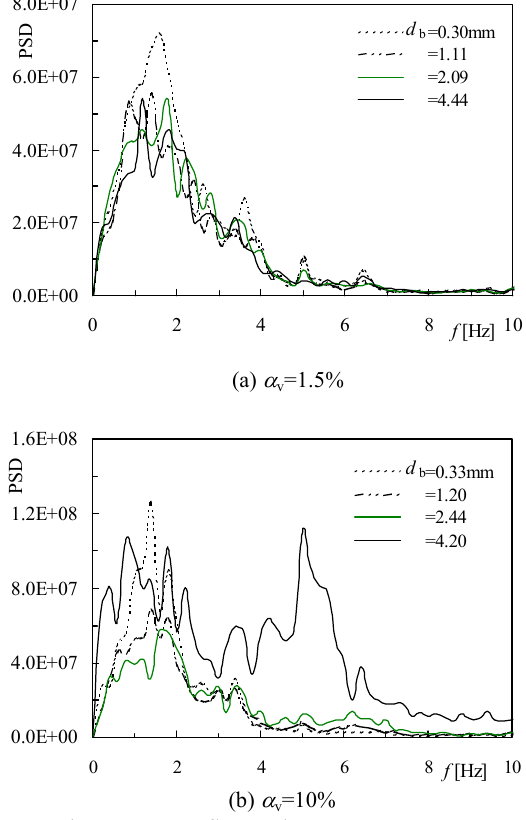
Fig.7 Pressure fluctuation measurements